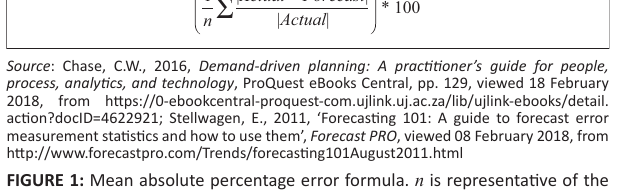
FIGURE 1: Mean absolute percentage error formula. n is representative of the number of periods over which the error was measured. TABLE 1: Positive and negative aspects of mean absolute percentage error. Positive Negative Mean absolute percentage error is best for working with large volumes of data (Stellwagen